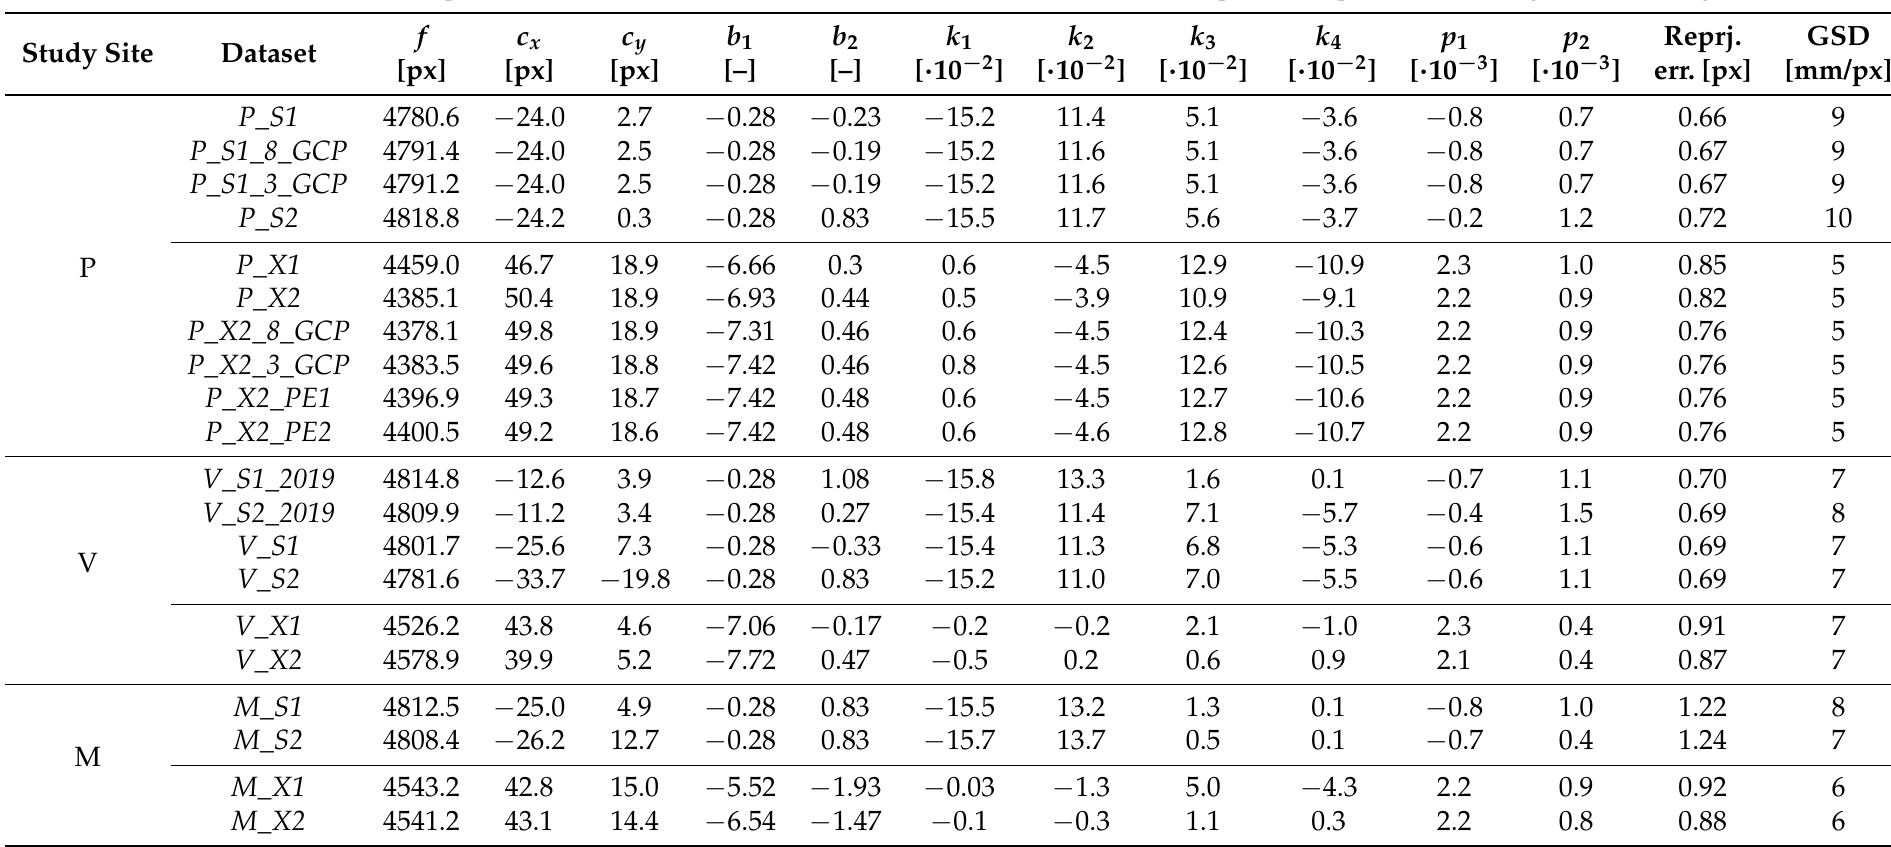
Table 3. Estimated camera parameter values for all datasets. In the last column the actual mean GSD is reported, computed after the image orientation